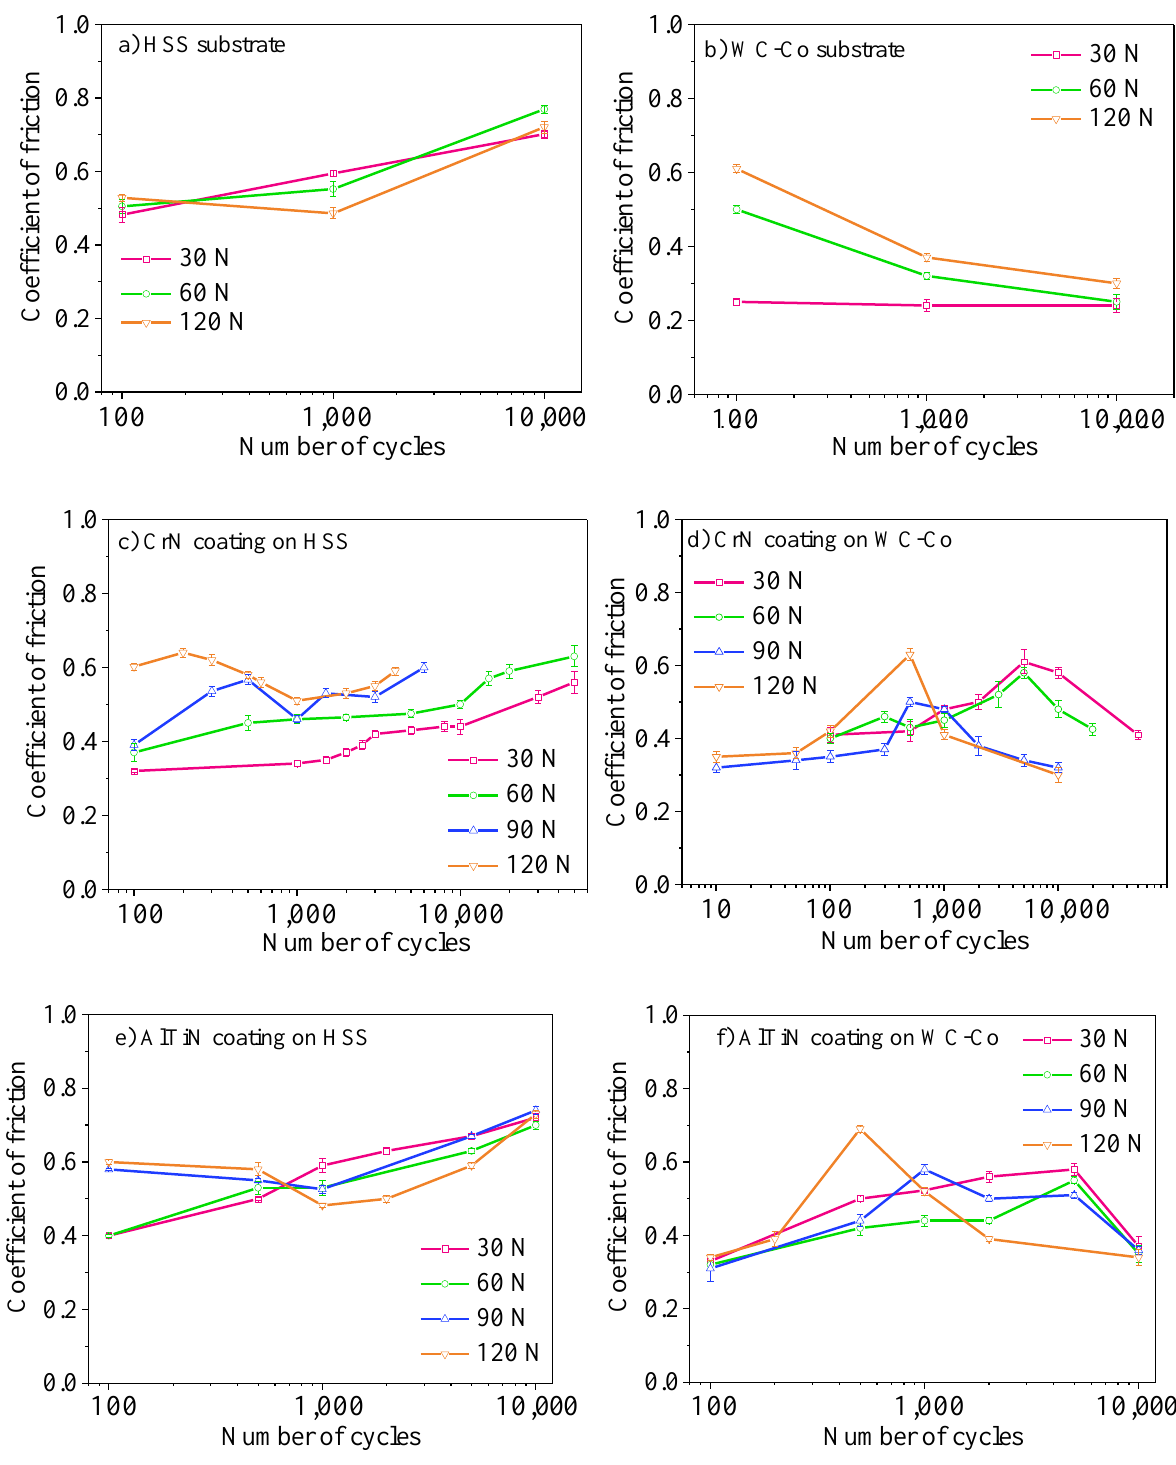
Figure 5. The final CoFs: ( a ) HSS substrate; ( b ) WC-Co substrate; ( c ) CrN coating on HSS; ( d ) CrN coating on WC-Co; ( e ) AlTiN coating on HSS; ( f ) AlTiN coating on WC-Co.